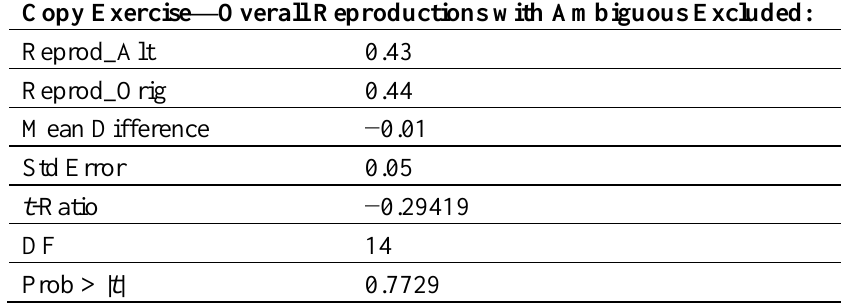
Table 3. (Alt.) Matched Pairs Comparison on Copy Exercise: Reproductions in Original versus Altered Drawings grouped by Plastic Values (Ambiguous Excluded).